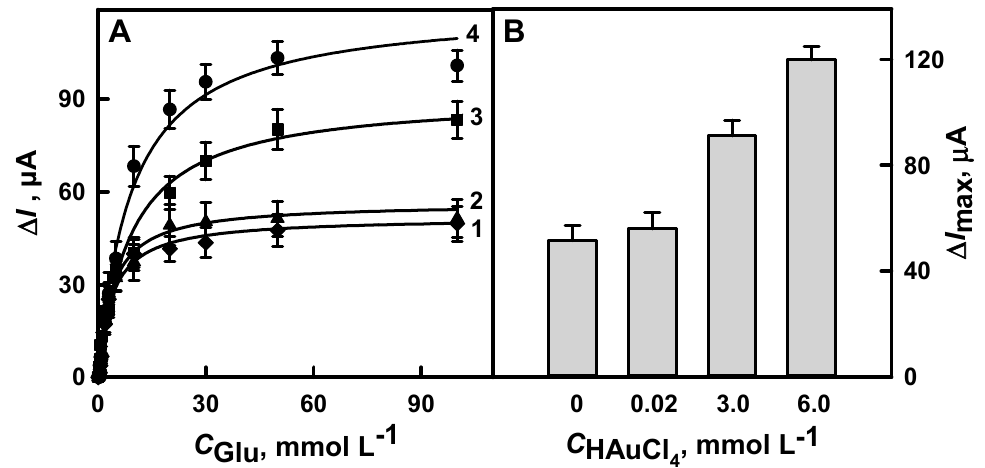
Figure 2. Calibration plots ( A ) and diagrams ( B ) of glucose biosensors based on DGNs electrochemically deposited using different concentrations of HAuCl 4 solution. Electrochemical deposition of gold nanostructures was performed in a solution of 0.1 mol L − 1 KNO 3 containing 0, 0.02, 3.0 or 6.0 mmol L − 1 of HAuCl 4 (curves 1, 2, 3 and 4, respectively) at constant − 0.2 V potential for 200 s. Amperometric response was measured in 0.05 mol L − 1 SA buffer with 0.1 mol L − 1 KCl (pH 6.0) and 2.0 mmol L − 1 PMS.